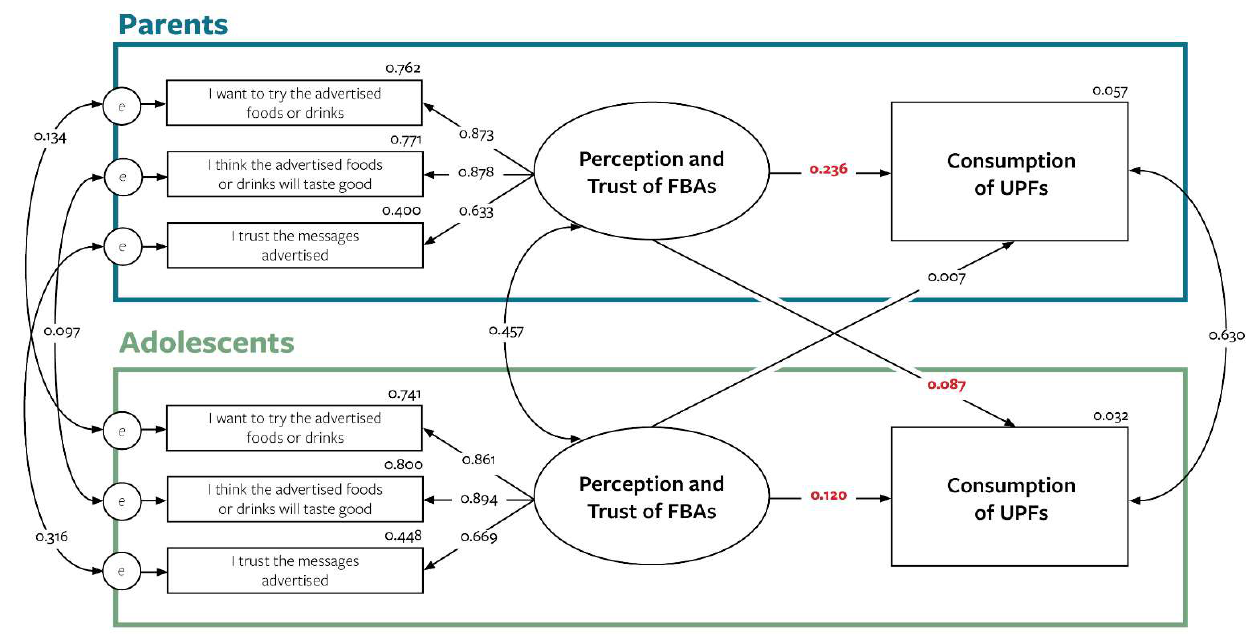
Figure 3. Actor and partner effects of perception and trust of FBAs and consumption of UPFs in parent-adolescent dyads. Significant regression coefficients are bolded in red. Model fit: ∆ χ 2 = 49.518, df = 13, p = 0.001; RMSEA = 0.042 (90% CI = 0.030 to 0.054), p = 0.85; CFI = 0.994; SRMR = 0.026; AIC = 39525.613.